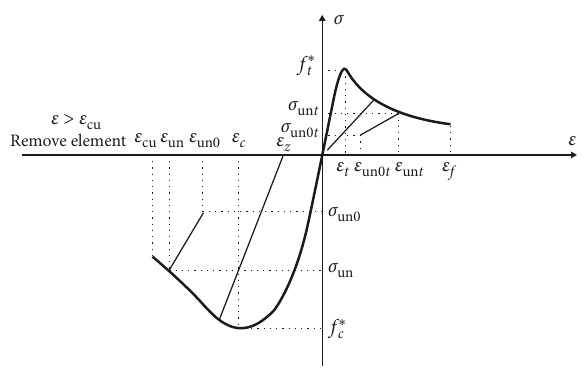
Figure 1: Constitutive model for